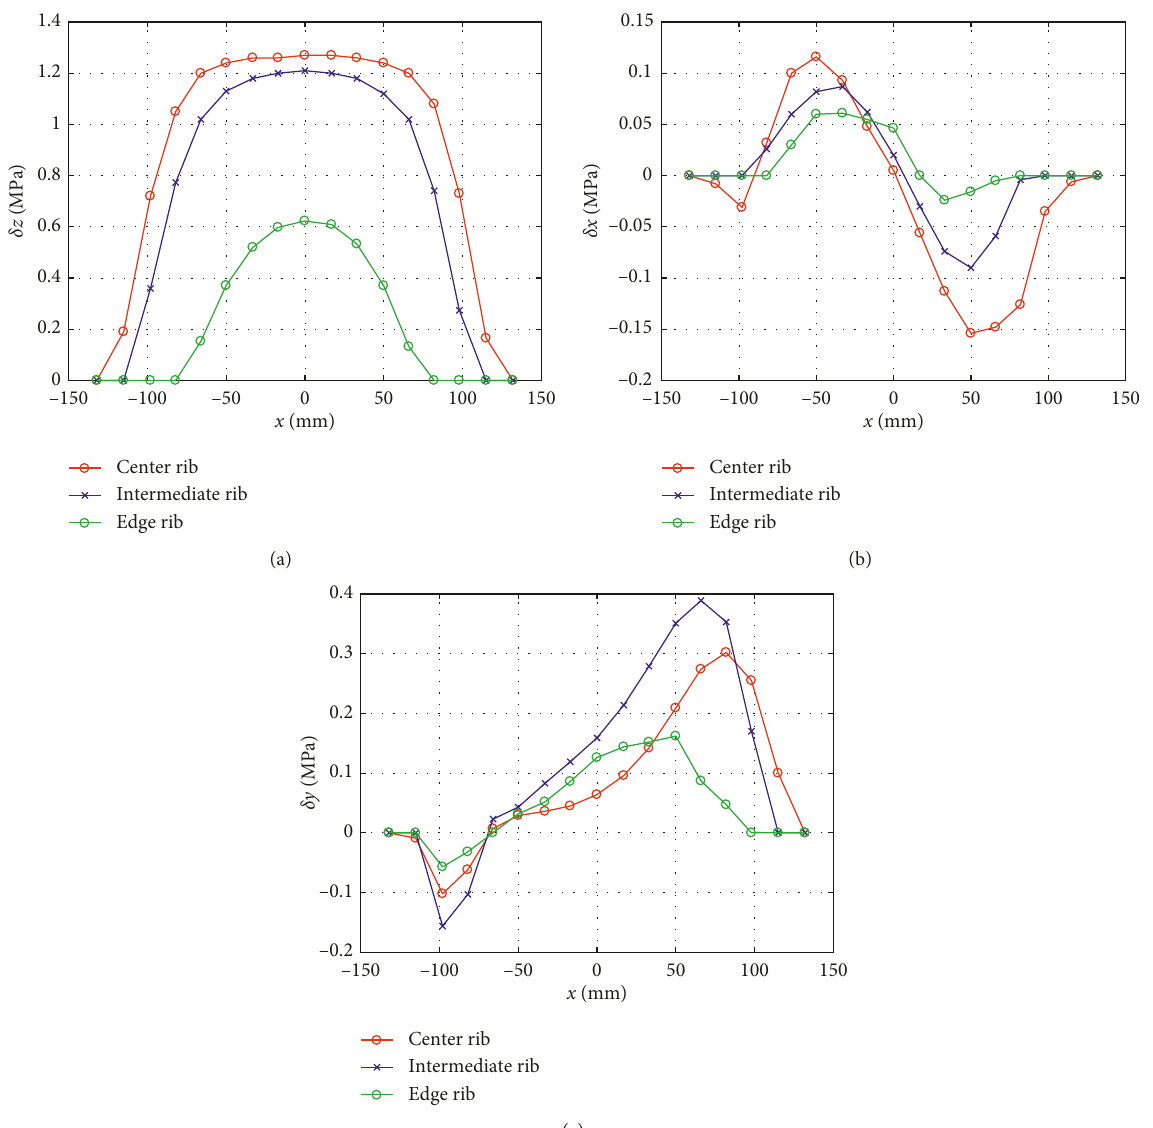
Figure 4: Comparison of contact stresses in (a) vertical, (b) longitudinal, and (c) transverse directions at free rolling